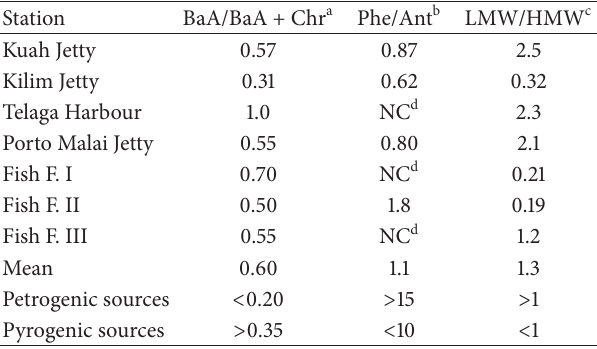
Table 5: Diagnostic PAH ratios in seawater and their possible